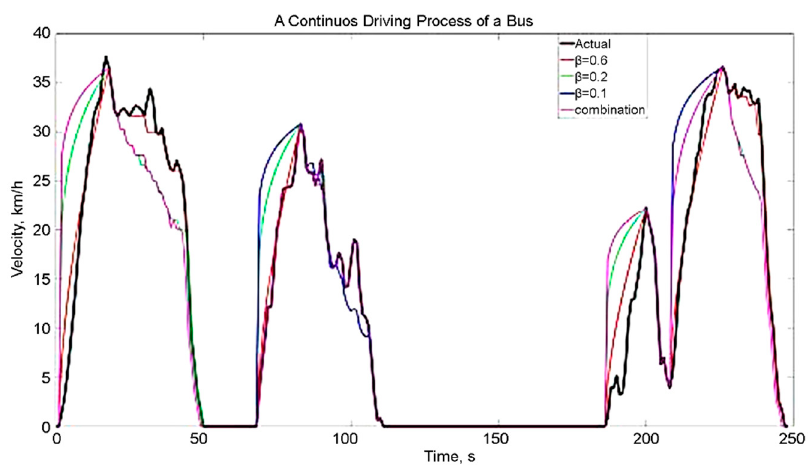
Figure 23. Dependence of speed on time before and after optimization.